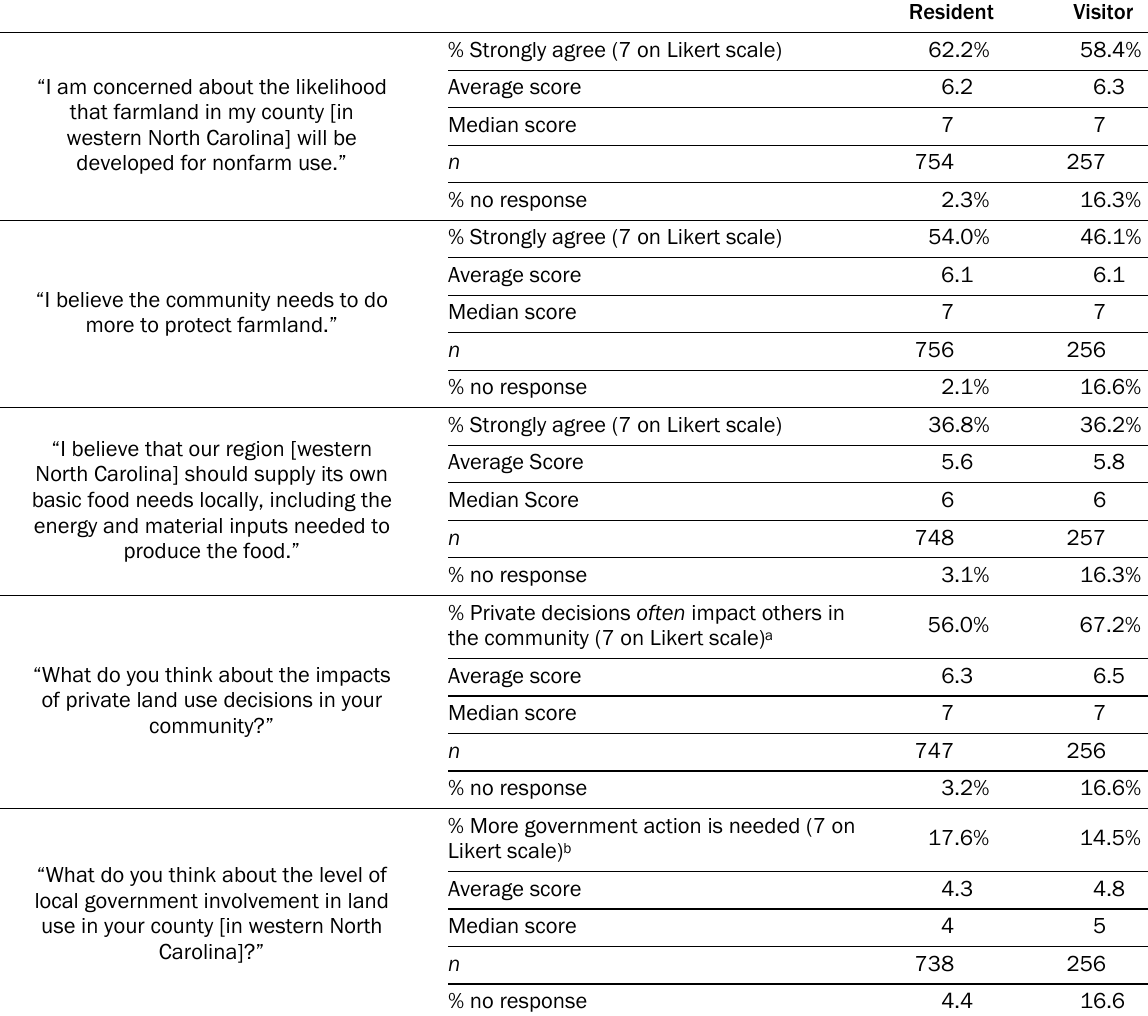
Table 11. Opinions about Farmland and Land Use Issues (1 = Strongly Disagree, 7 = Strongly